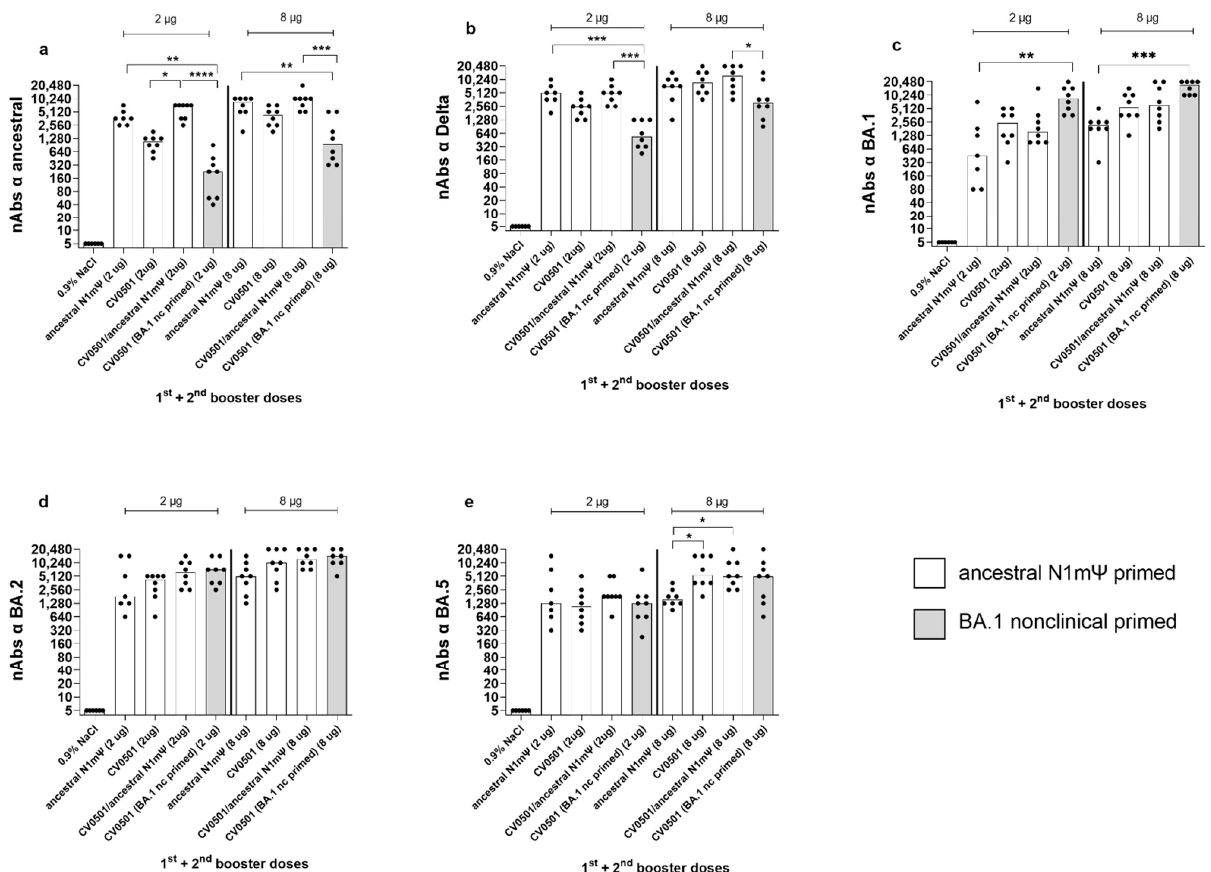
Figure 4. CV0501, ancestral N1m Ψ and bivalent CV0501/ancestral N1m Ψ boost cross-nAb titers after priming with ancestral N1m Ψ vaccine. Wistar rats ( n = 8/group) were immunized i.m. on Days 0 and 21 with 2 µ g or 8 µ g of ancestral N1m Ψ (white bars) or BA.1 nonclinical (grey bars) and boosted on Days 105 and 189 with either CV0501, the bivalent combination CV0501/ancestral N1m Ψ or ancestral N1m Ψ . Animals immunized with 0.9% NaCl Buffer ( n = 6/group) were used as negative controls. Neutralizing Abs against ancestral ( a ), Delta ( b ), BA.1 ( c ), BA.2 ( d ) or and BA.5 ( e ) SARS-CoV-2 variants were assessed in sera taken on Day 217. Each dot represents an individual animal and bars represents the median. One-way ANOVAs and Kruskal-Wallis tests for the 2µg and 8µg doses were performed. * p < 0.05, ** p < 0.01, *** p < 0.001, **** p < 0.0001. Table 3. Analyses of median nAb production against SARS-CoV-2 variants after booster vaccination with CV0501 alone, ancestral N1m Ψ alone, or bivalent CV0501/ancestral N1m Ψ . Median nAb Titers vs. SARS-CoV-2 Variants on Day 217